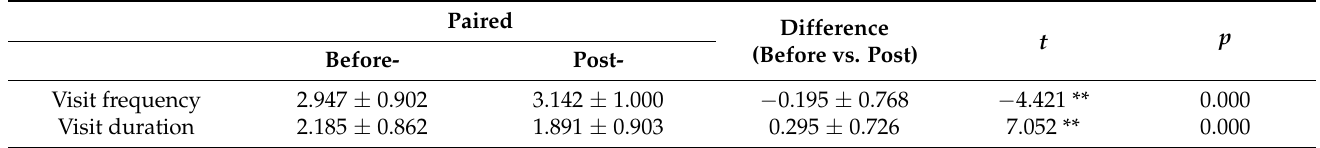
Table 5. Paired sample t -test results of visit frequency, accompany mode, and visit duration before and after the pandemic. Paired Difference t p (Before vs. Post) Before-